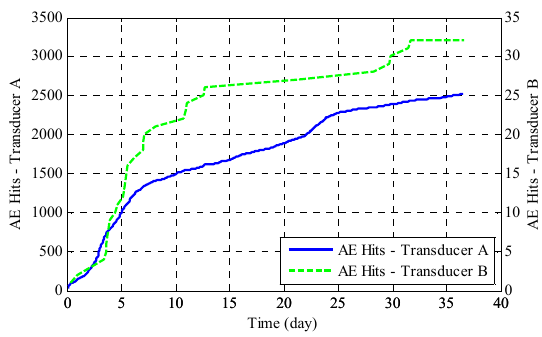
Figure 6. AE hits during the accelerated corrosion test.